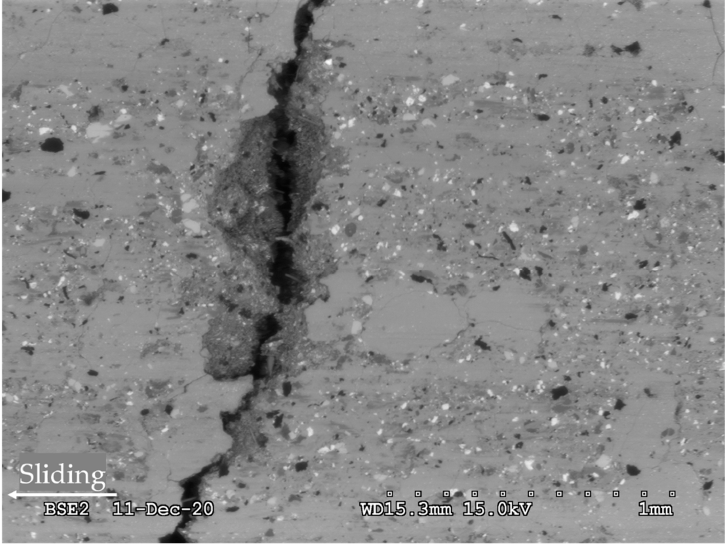
Figure 12. Worn surface of an NAO pad. SEM backscattered electron image.